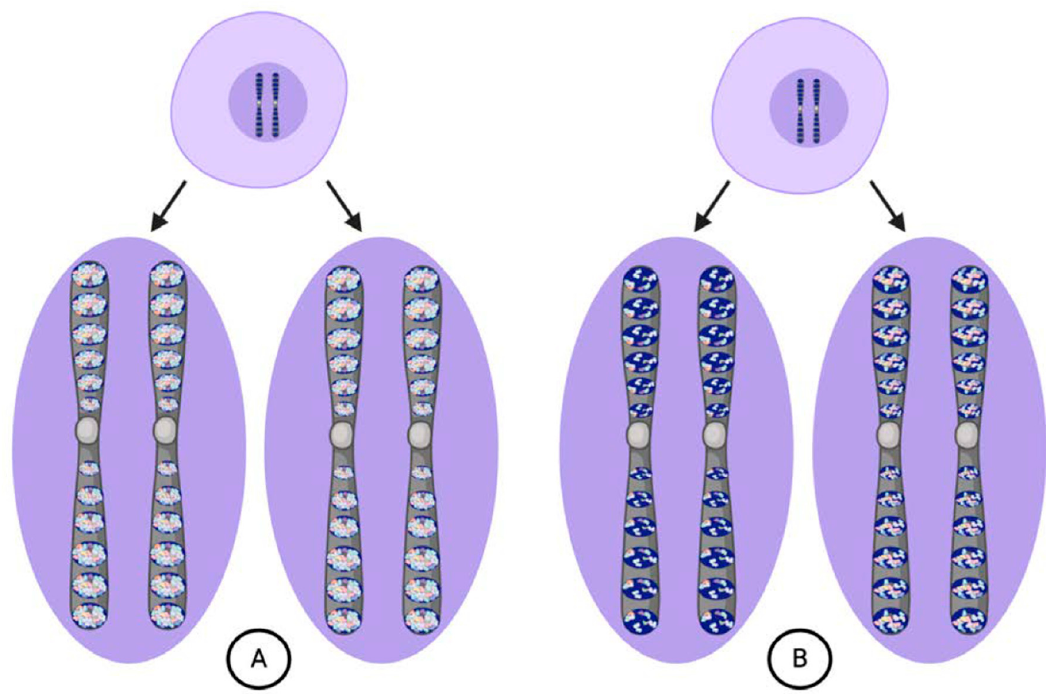
Figure 2. According to Weismann, cells can undergo either ordinary ( A ) or embryogenic divisions ( B ). ( A ) Ordinary divisions produce daughter cells with chromosomes bearing vital unit composition identical to the parental cell and maintain the germ plasm intact from the zygote through mature germ cells. ( B ) Embryogenic divisions produce daughter cells with chromosomes that bear different determinants in their ids depending upon their destined cell lineage.